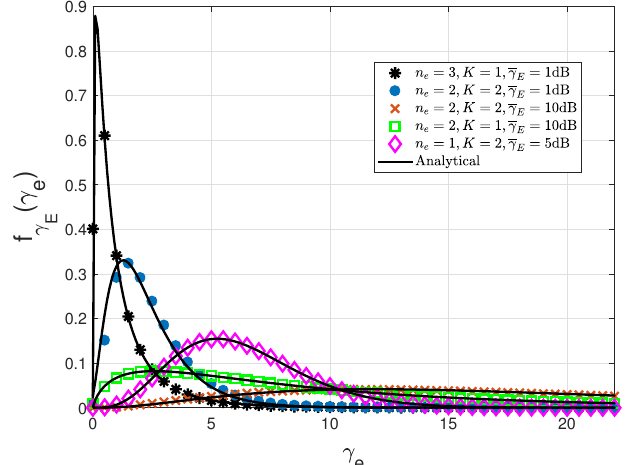
Figure 2. The PDF of the received SNR at the eavesdropper ( γ E ) for multiple values of cascade level of the wiretap channel ( n e ) and multiple number of antennas at E ( K ) . κ e = 1 and µ e = 2. Using (9) and ([28] Equation (26)), the CDF of γ E can be given by